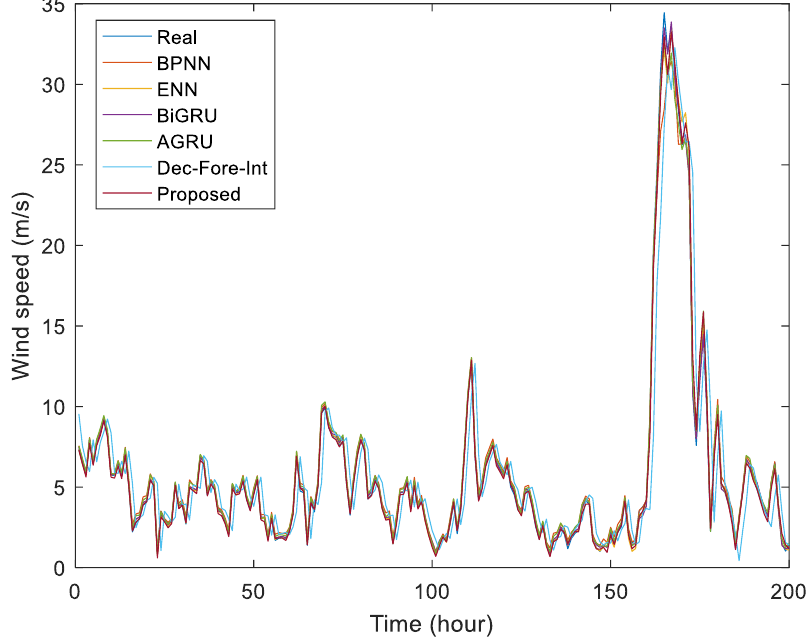
Figure 13. Predictions of different hybrid neural network models.